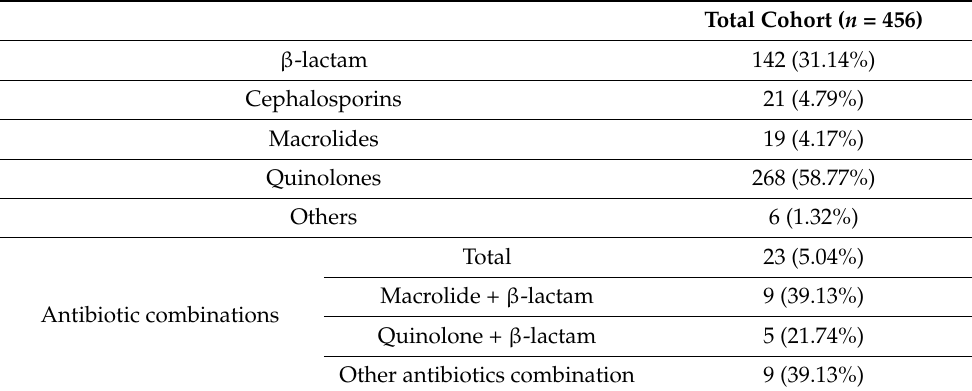
Table 4. Antibiotic treatments used in CAP managed in primary